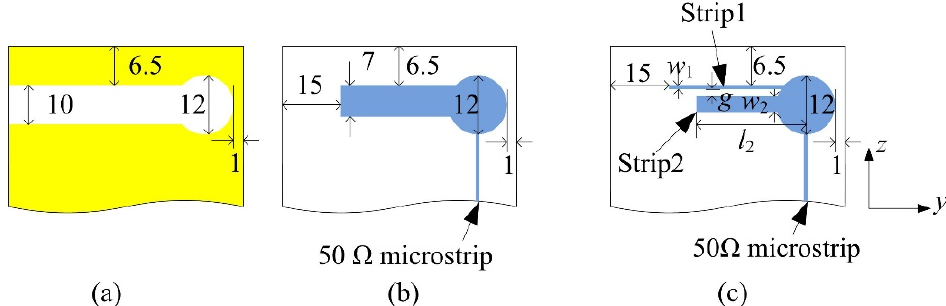
Figure 1. Configuration of the proposed antenna and reference antenna without ferrite slab (unit: mm). ( a ) Bottom layer of the two antennas. ( b ) Top layer of the reference antenna. ( c ) Top layer of the proposed antenna. (Unit: mm).